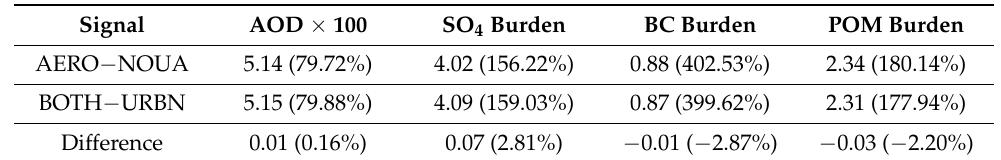
Table 1. NDJ-mean anthropogenic aerosol (AA)-induced changes in aerosol optical depth (AOD; unitless) and column burdens (in mg/m 2 ) of sulfate (SO 4 ) aerosols, black carbon (BC) aerosols, and primary organic matters (POMs) averaged over eastern China (105°–125° E, 20°–45° N) from